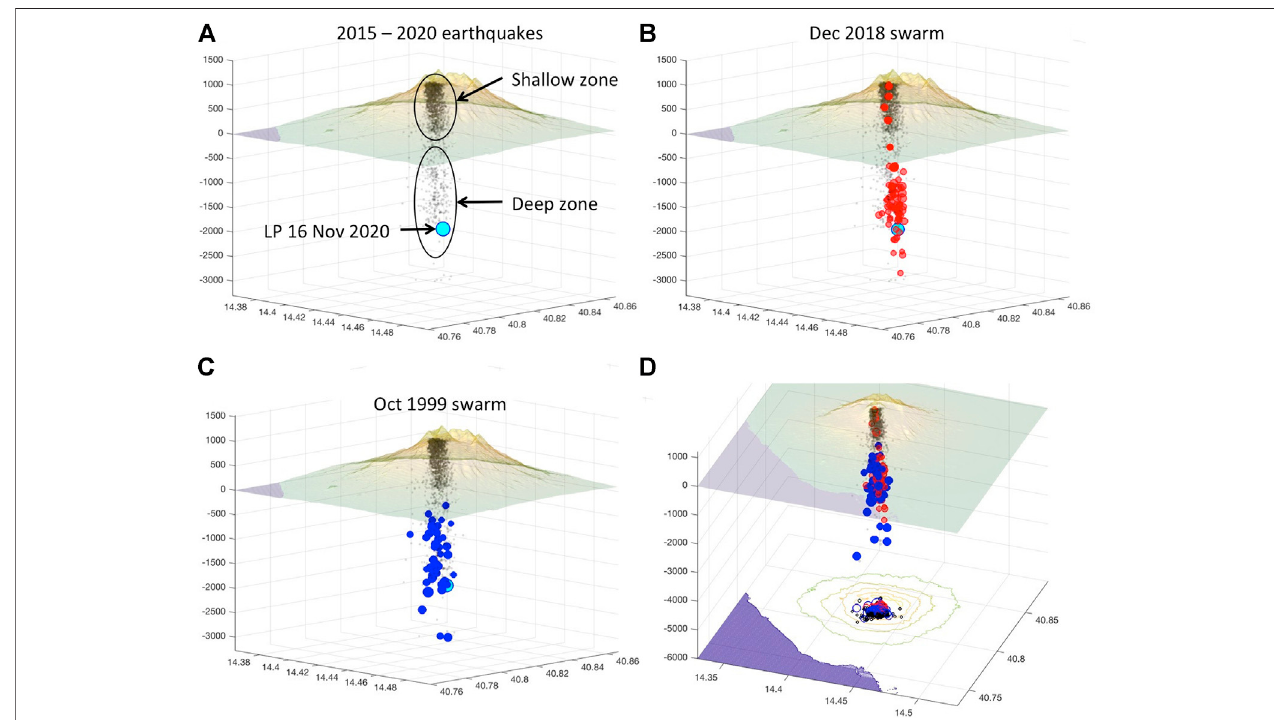
FIGURE 9 | Earthquake locations at Vesuvius. (A) Location of earthquakes recorded on Vesuvius between January 2015 and November 2020. The events are indicated with a black dot (70% transparency). The cyan circle indicates the location of the LP transient recorded on November 16, 2020 at 5:58:55 (UTC). The two ellipses surround the “ shallow ” and “ deep ” seismogenic zones. (B) The red circles highlight the earthquakes of the swarm that occurred on November 30 December 1, 2018. (C) The blue circles indicate the earthquakes of the October 1999 swarm. The plot in panel (D) shows the comparison between the locations of the two swarms. In all plots the location of the LP transient is reported asa cyan circle. The sizes of the red and blue circles are proportional tothe magnitudes ofearthquakes of 2018 and 1999 swarms, respectively. The locations of the swarms and the LP transient are included in the supplementary Datasheet S1 .